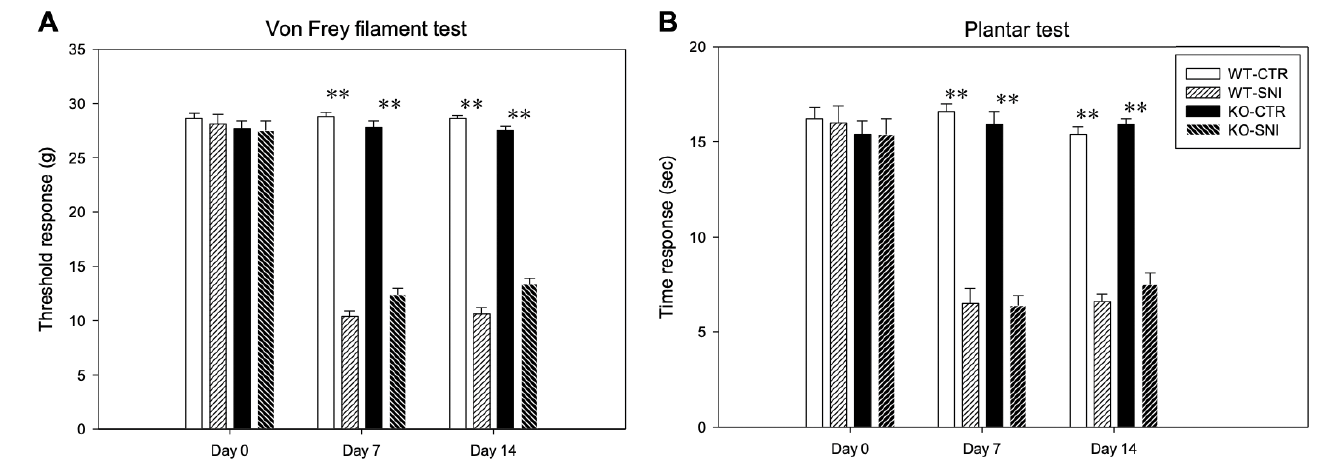
Figure 1. Behavioral analysis. WT and KO mice, tested with von Frey filament test ( A ) and thermal plantar test ( B ) for baseline sensitivity (Day 0) and 7 (Day 7) and 14 days (Day 14) after SNI. Data are expressed as the mean ± SEM (** p ≤ 0.001).